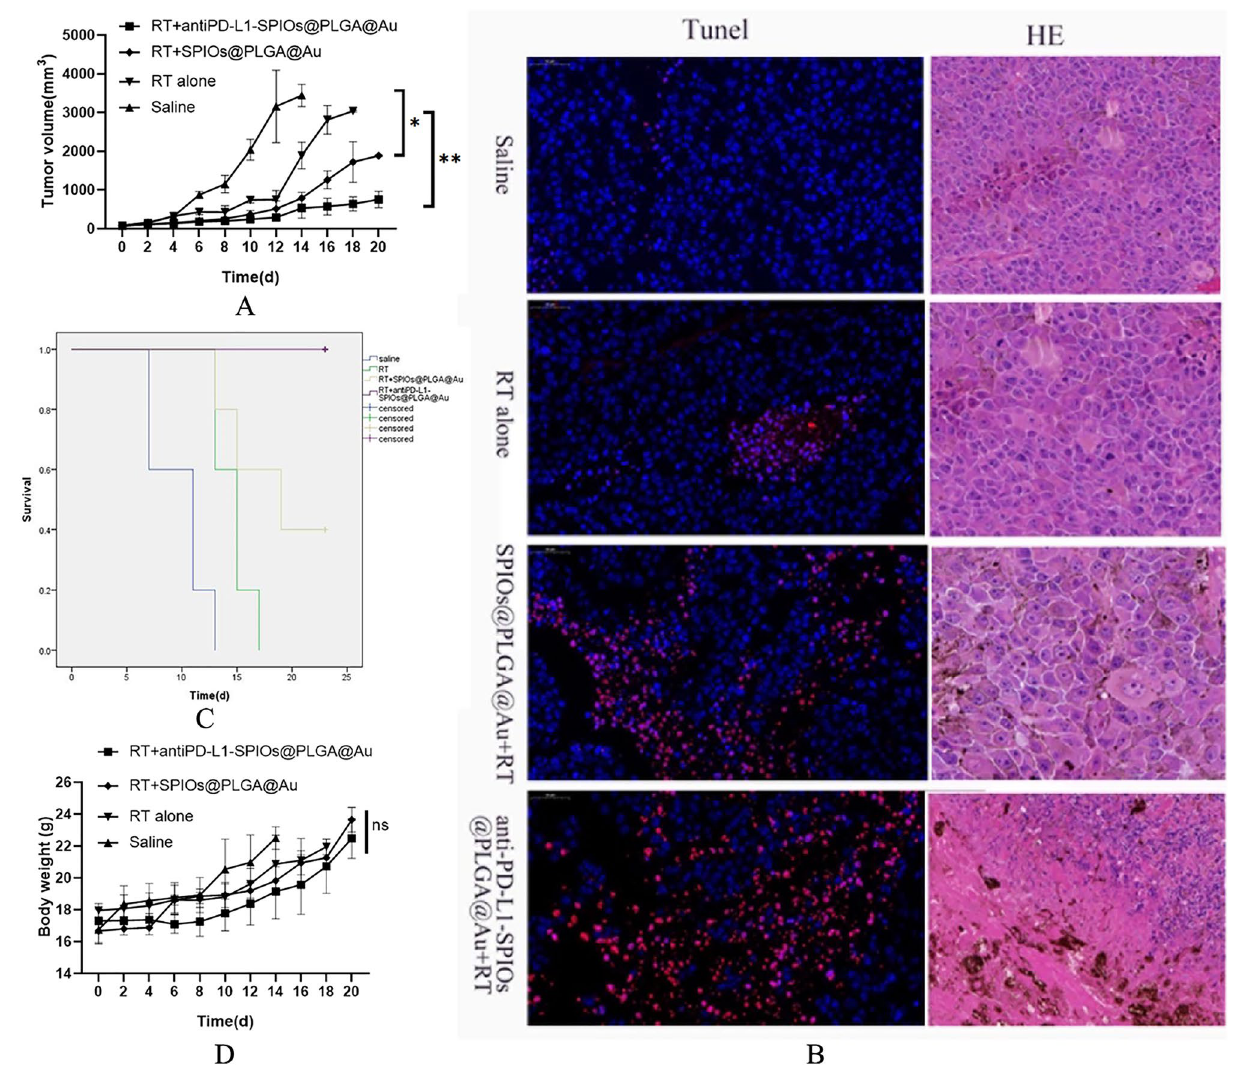
Figure 3. ( A ) Tumor growth in different groups (n = 4 per group) ( B ) Tunel and HE staining of tumor tissues. ( C ) Survival curves of tumor-bearing mice in different groups. ( D ) Body weight changes of B16F10 tumor- bearing mice in different groups. (ns: not significant, * p < 0.05, ** p <